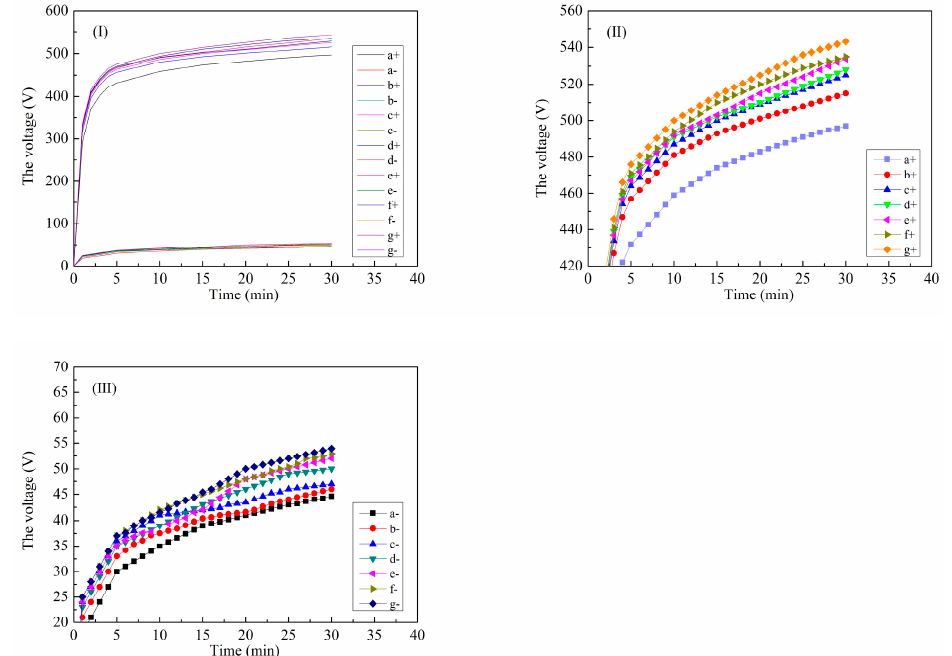
Figure 2. Variation curves of the voltage at different anode pulse-widths during microarc oxidation. ( I ) variation curves of anode and cathode voltages; ( II ) variation curves of anode voltages; ( III ) variation curves of cathode voltages; (a): 1000 µ s; (b): 1500 µ s; (c): 2000 µ s; (d): 2500 µ s; (e): 3000 µ s; (f): 3500 µ s; (g): 4000 µ s. Table 1. Microarc oxidation process parameters for coatings formed on aluminum alloys at different anode